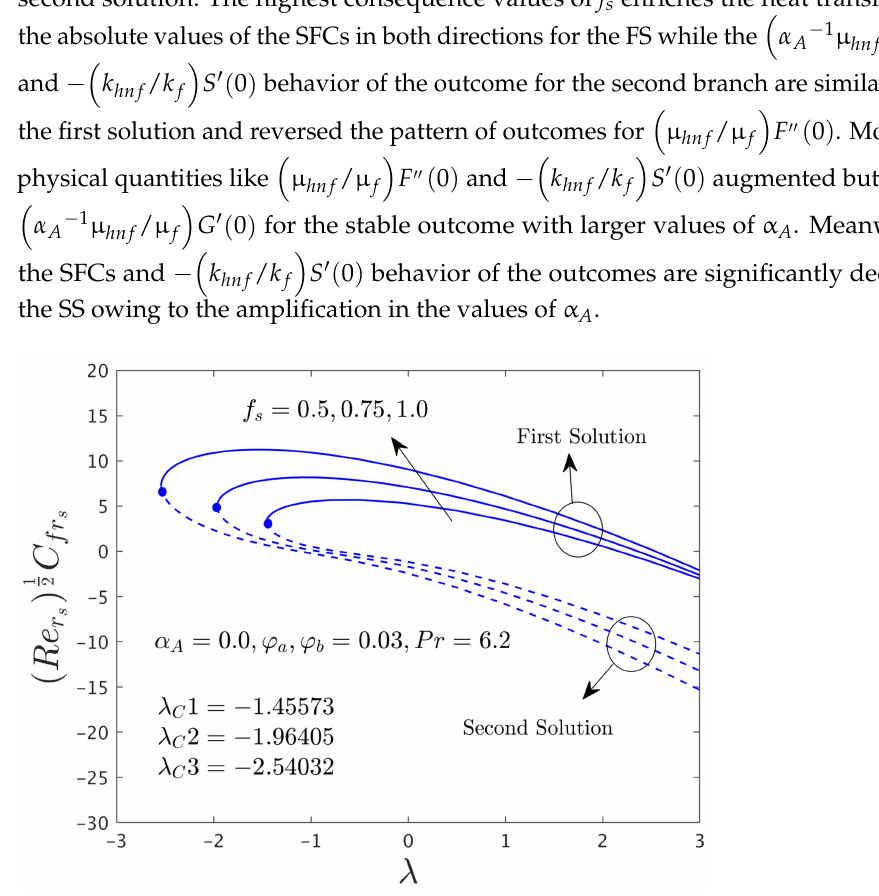
Figure 2. Deviations of Re 0.5 r